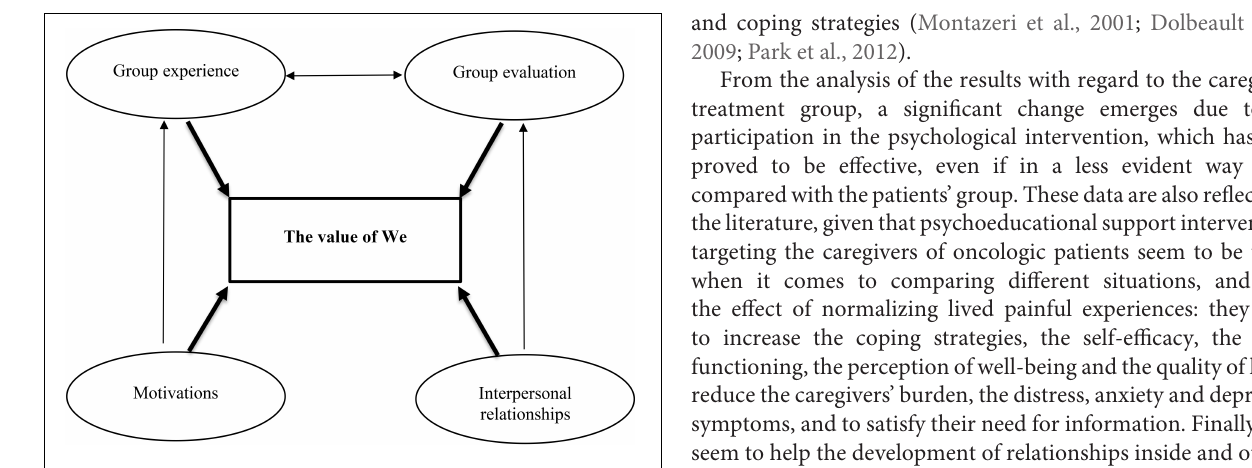
FIGURE 2 | Graphic representation of the theory emerging from